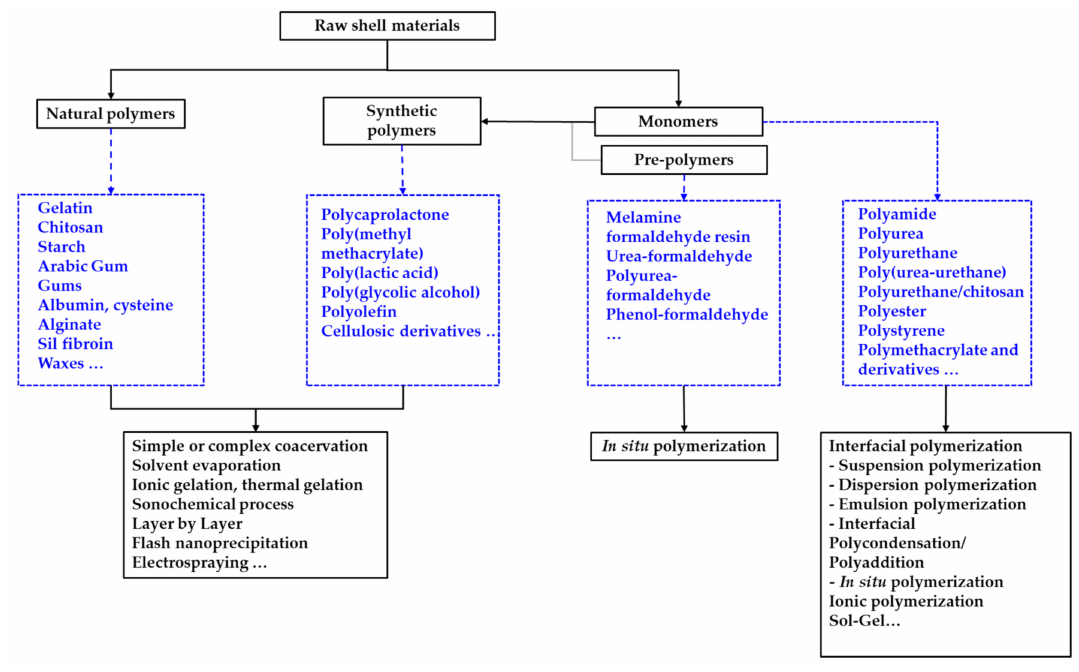
Figure 3. Microencapsulation processes based on raw